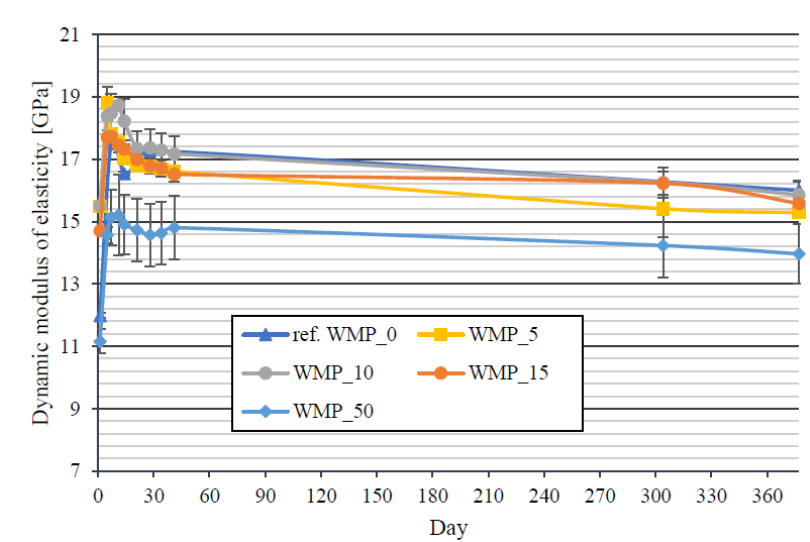
Figure 4. Time dependence of dynamic modulus of elasticity (with standard deviation).